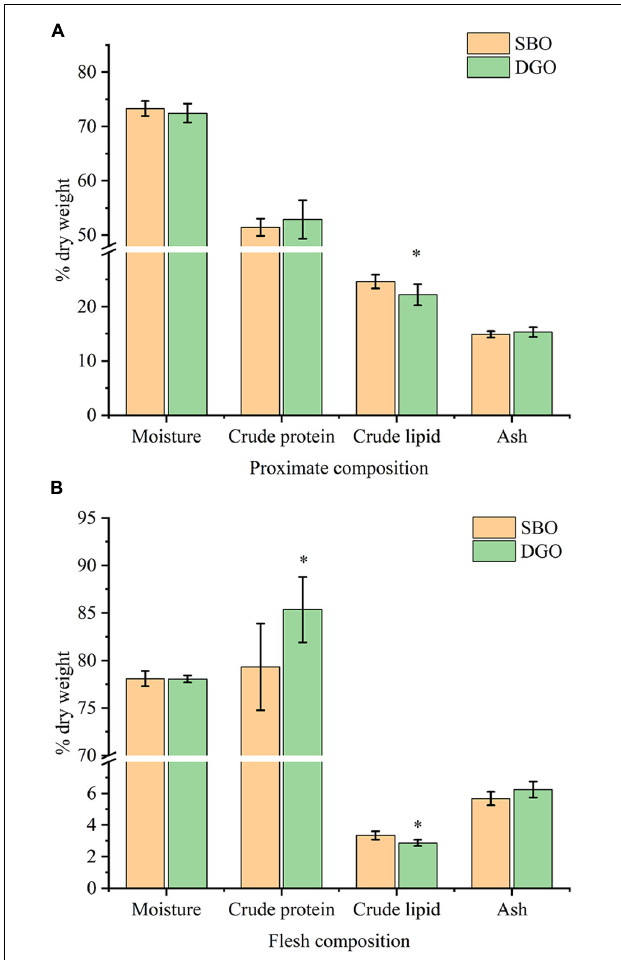
FIGURE 6 | Effects of DAG-enriched oil (DGO) on the nutrient composition of whole-body (A) and muscle tissues (B) in fish. ∗ indicates significant differences between the SBO and DGO groups at P < 0.05.